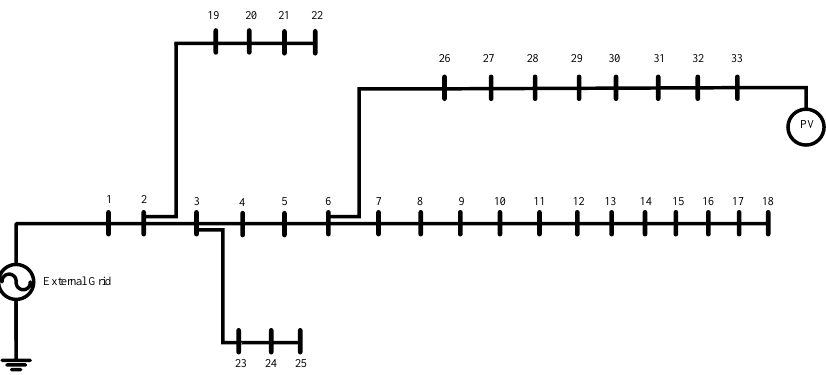
Figure 12. Single-line diagram of IEEE 33-bus system.